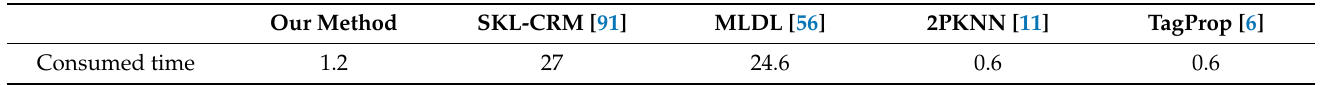
Table 4. Time consumed, in seconds, for annotating one image with five concepts. Our